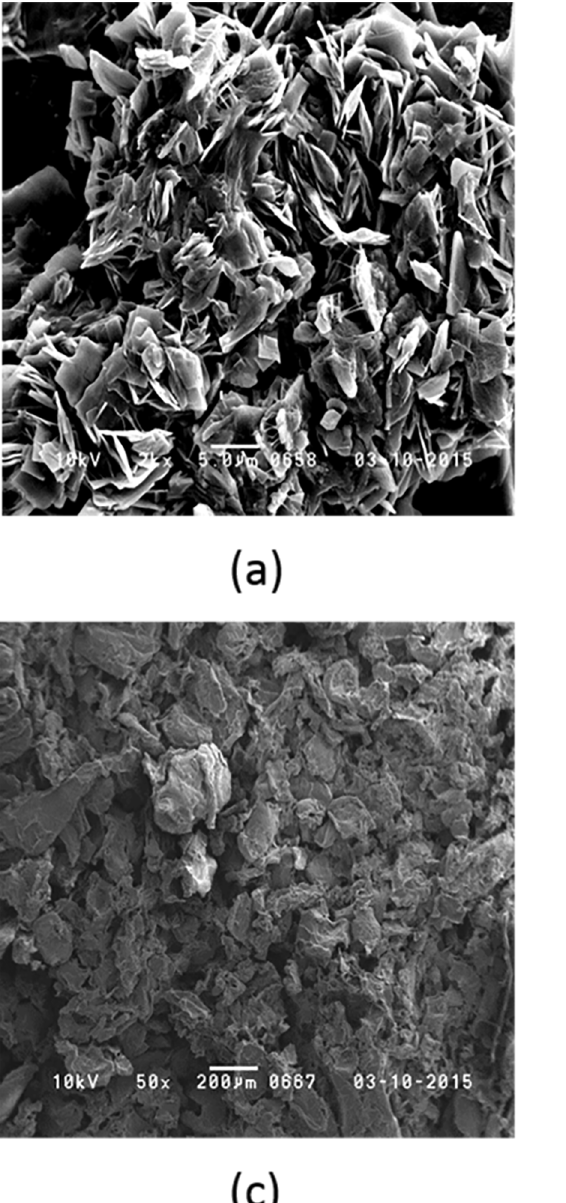
value m /K ) indicated max m and K on enzyme max m